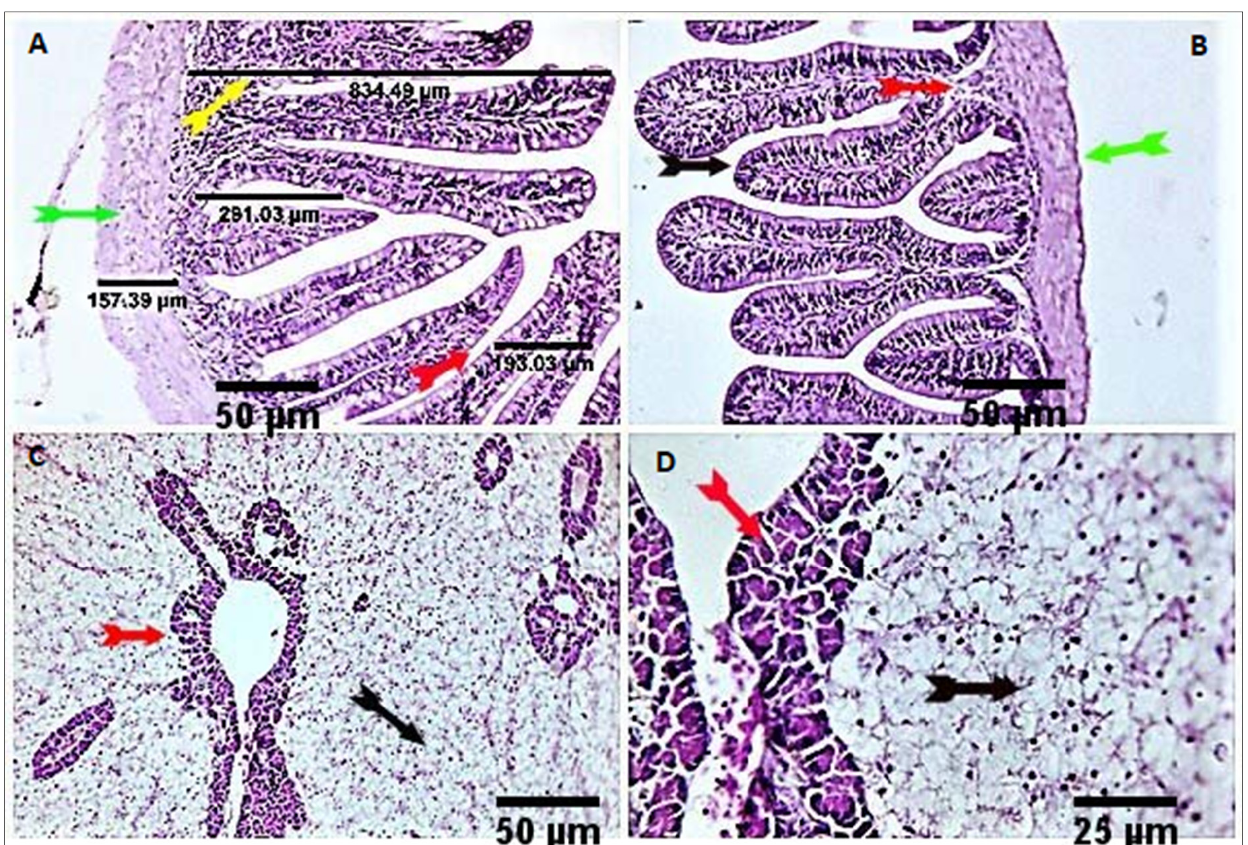
Figure 2. Stained sections of the anterior and posterior intestines of the control group showed normal histological structure ( A , B ) with variable numbers of goblet cells (yellow and red arrows). The liver of the control group showed normal histomorphological structures with normal features of hepatopancreatic structures (red arrows) and hepatic cord orientation (black arrows) ( C , D ). Scale bars = 25 µ m, 50 µ